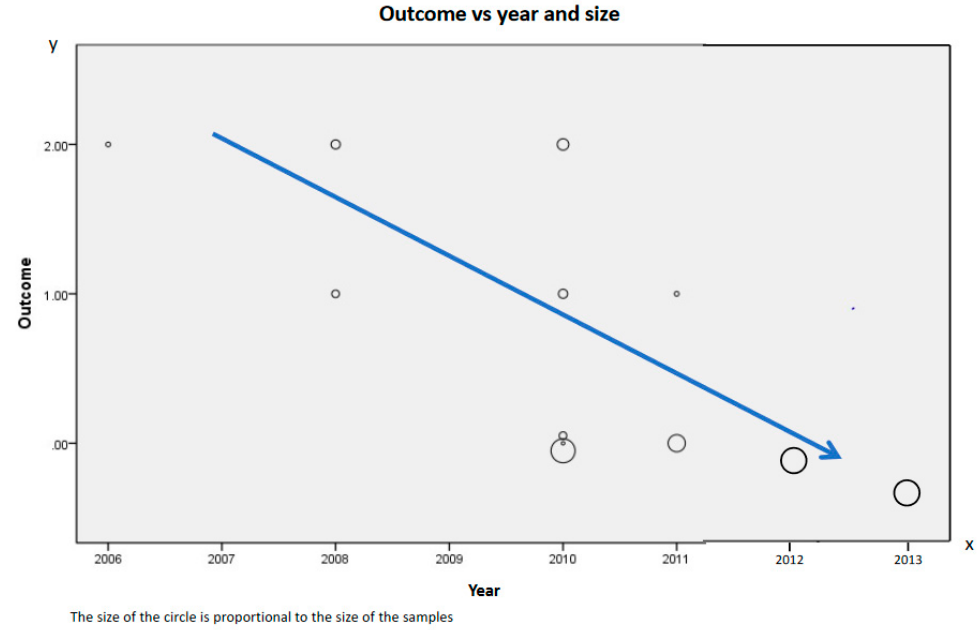
Figure 1. The outcome from 2 = positive result to 0 = null result is shown on the y axis. The year of publication is on the x axis.